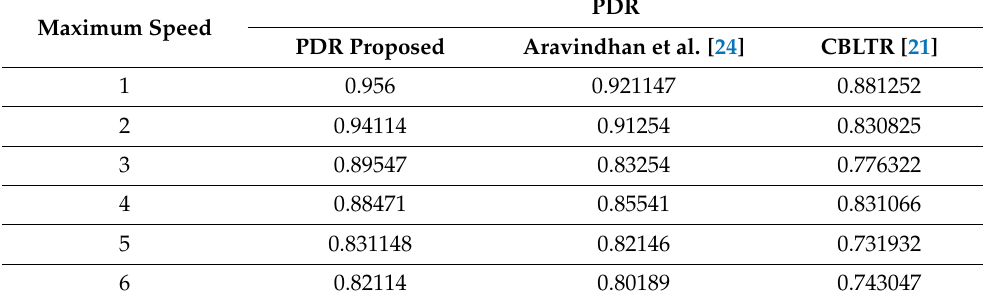
Table 3. PDR versus